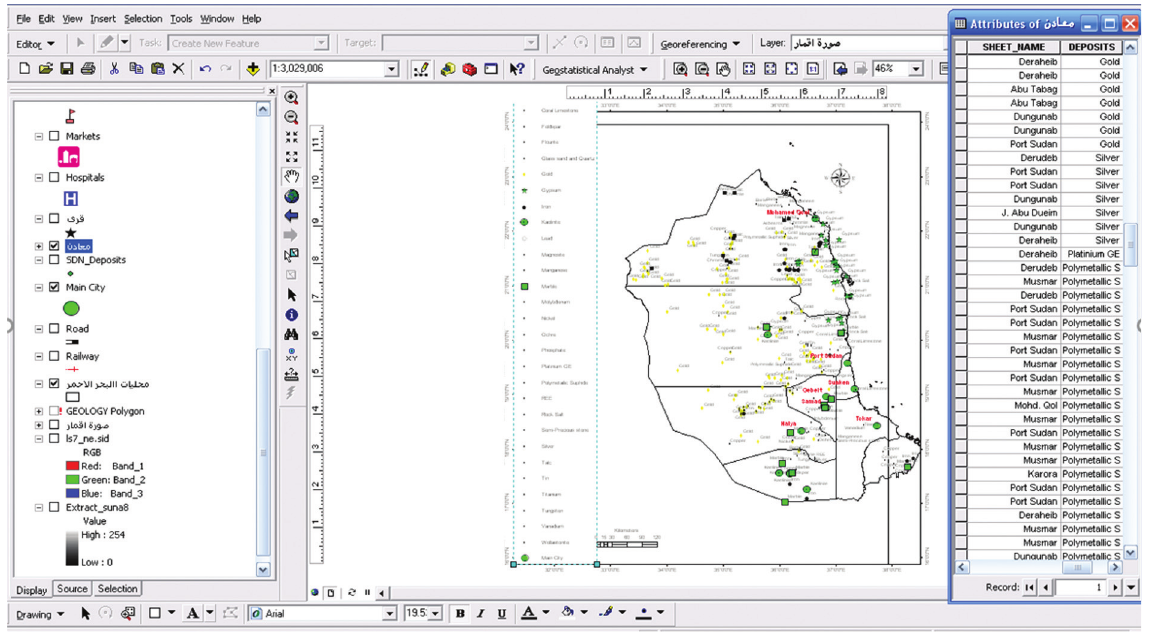
Figure 7: A map showing the mineral resources in the Red Sea area.